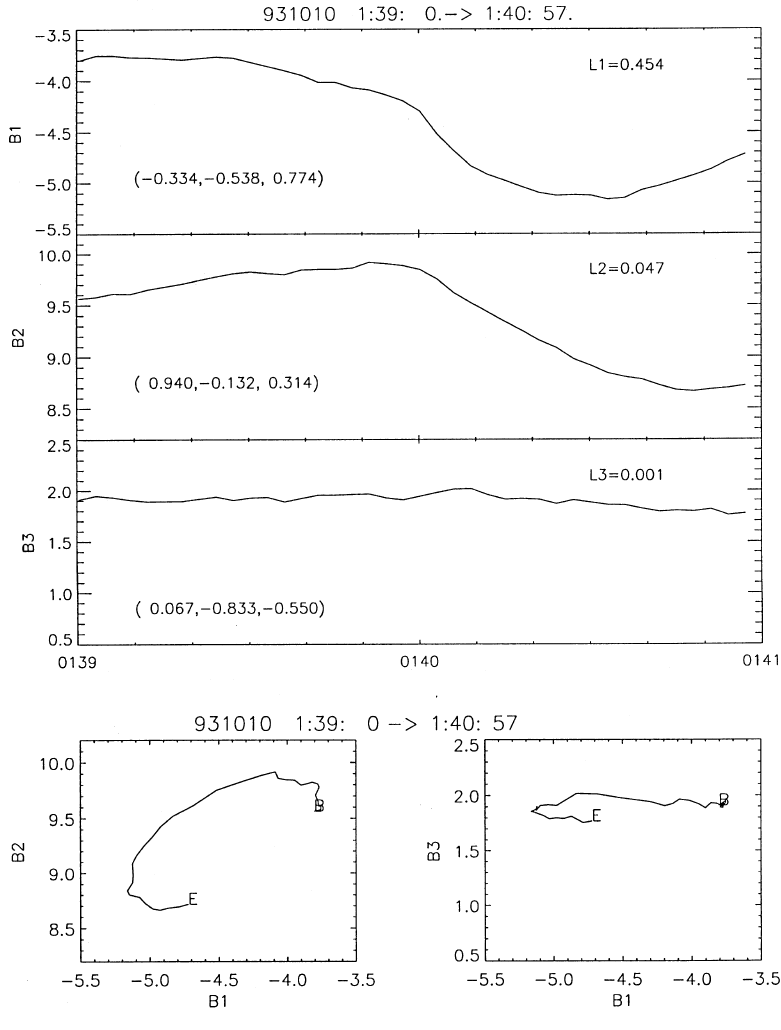
Fig. 8. 3 s averages of the GEOTAIL magnetic field data across the travelling compression region event A, displayed in principal axis coordinates. Hodograms of the field variation in two orthogonal planes are shown in the bottom